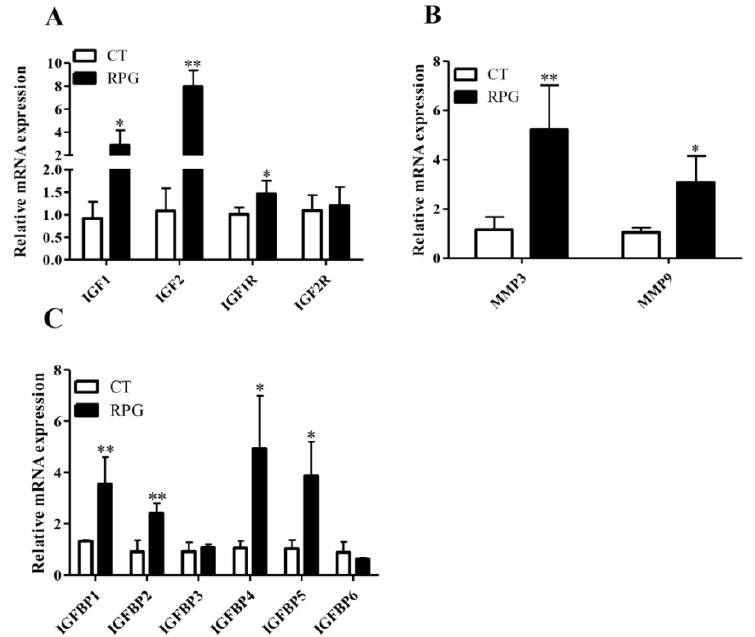
Figure 3. Relative mRNA expression levels for ( A ) IGF1, IGF2, IGF1R, IGF2R, ( B ) MMP3, MMP9 and ( C ) IGFBP1-6 in the endometrium of post-natal dairy cows fed with RPG supplementation compared with the control diet (CT) during the experimental period. Data are presented as the means ± SD. * p < 0.05, ** p < 0.01.